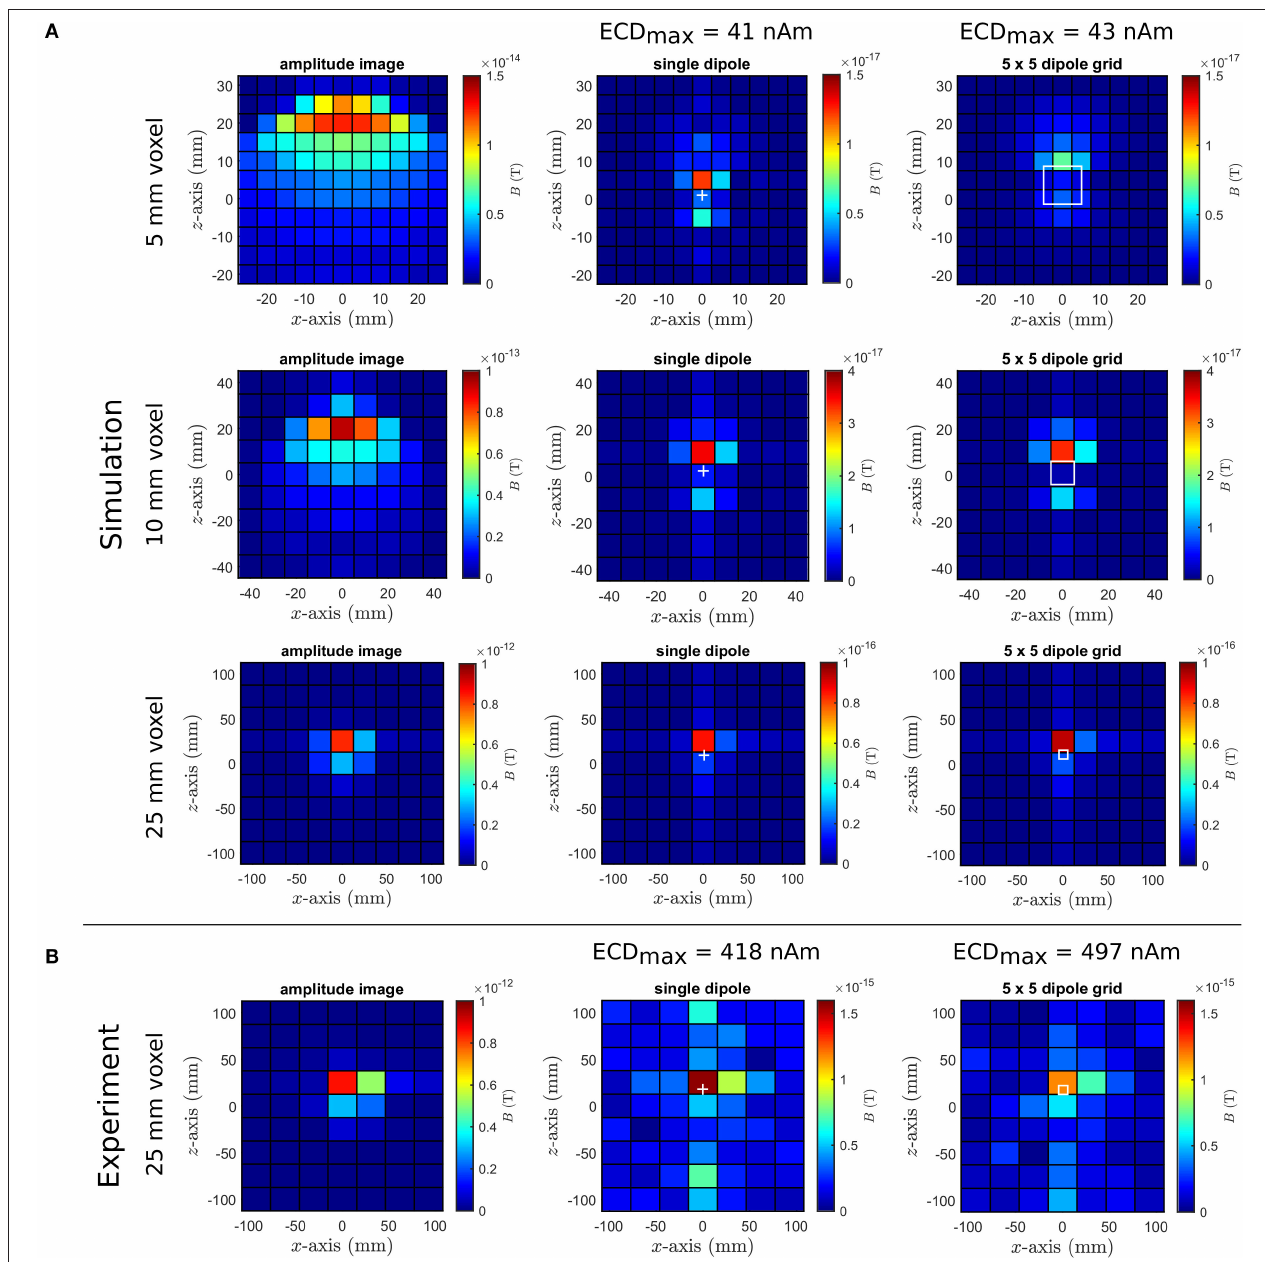
FIGURE 7 | (A) Noise-free dcNCI simulations with voxel size of 5 mm (top), 10 mm (middle), and 25 mm (bottom) for 35 mm deep dipoles. Images were phase adjusted to obtain maximum 1 S max which increases with voxel size; only for 5 mm is there a significant difference between the single dipole and the dipole grid. (B) Phantom experiments with nearly isotropic voxel size of 25 mm ( 1 x ≈ 28 mm) and ∼ 10 × stronger ECD max to enable clear identification of dipole activity in the presence of noise and artifacts. In all cases, amplitude images of the phantoms are shown on the left, difference amplitude images of the single dipole in the middle and of the dipole grid on the right. The cross and square denote the position of the single dipole and the dipole grid,